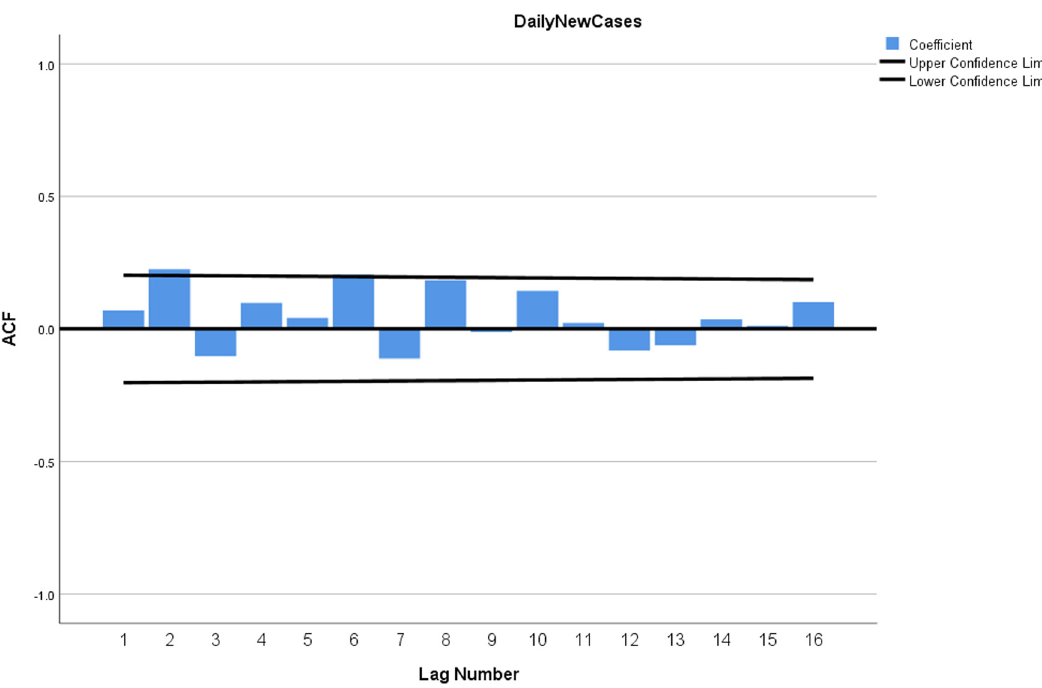
Figure 4: ACF of the di ff erenced